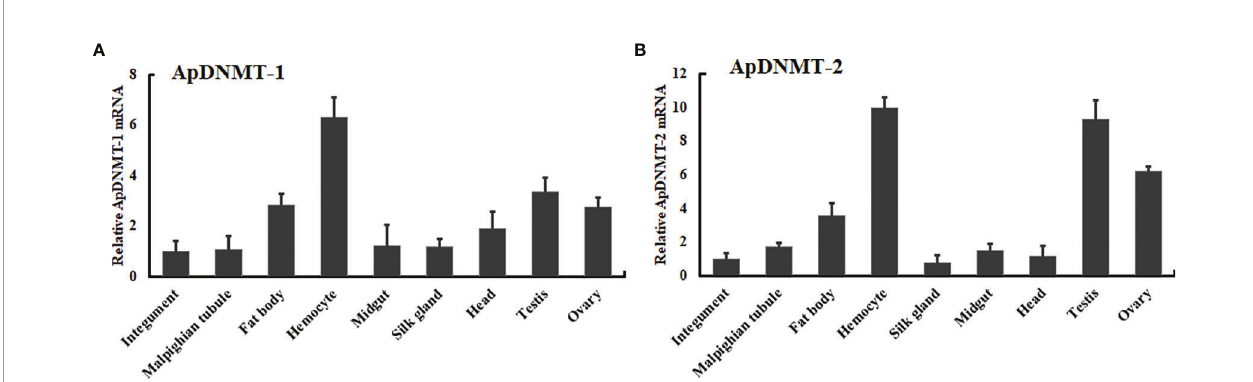
FIGURE 5 | Tissue distribution pro fi les of ApDNMT-1 and ApDNMT-2 in various tissues of A. pernyi (A) Analysis of ApDNMT-1 transcript expression in various tissues of silkworm larvae by qRT-PCR, (B) the ApDNMT-2 transcript expression in various tissues of silkworm larvae by qRT-PCR. The mRNA level in the midgut was used as the calibrator. Bars exhibit the mean ± S.E (n =